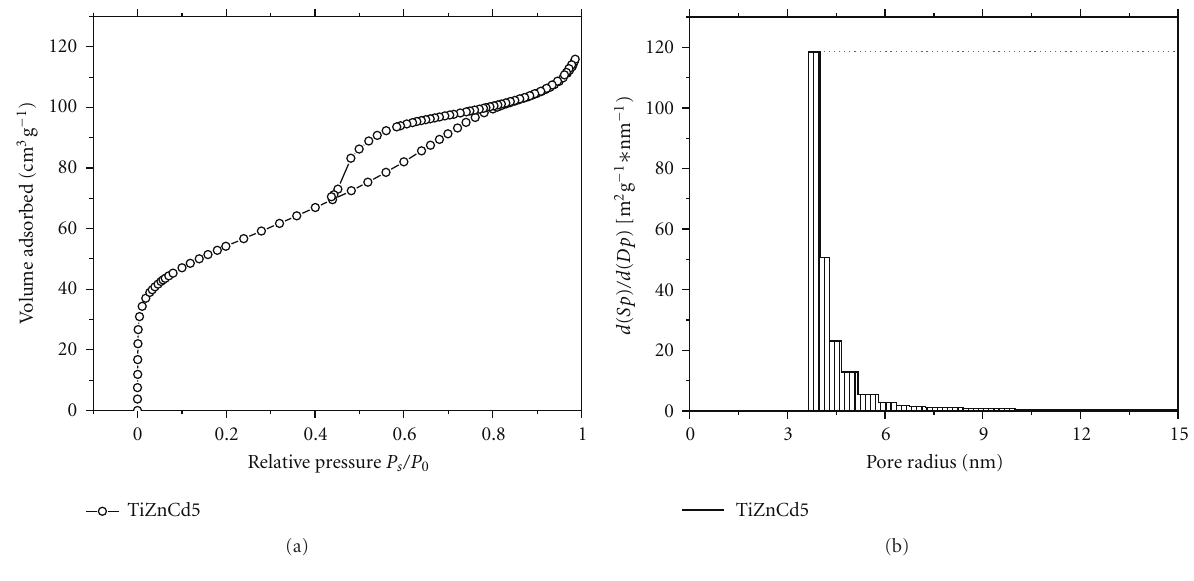
Figure 6: Hysteresis loop and pore size distribution of sample TiZnCd5. Table 3: Surface area, porosity, and EDX analysis of nanocomposites TiO 2